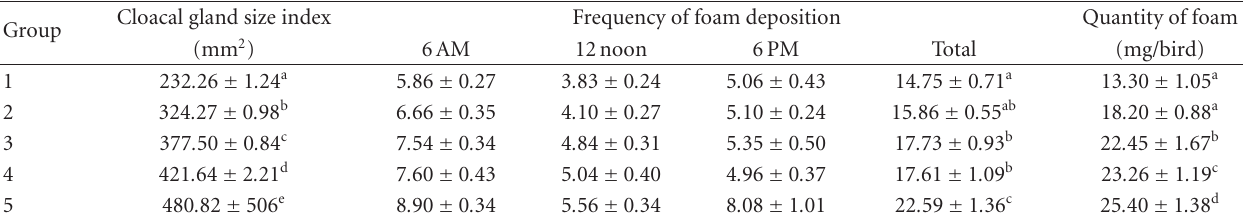
Table 1: Cloacal gland index, frequency of foam secretion, and quantity of foam in Japanese quail (mean ± S.E.M., n = 12). Group